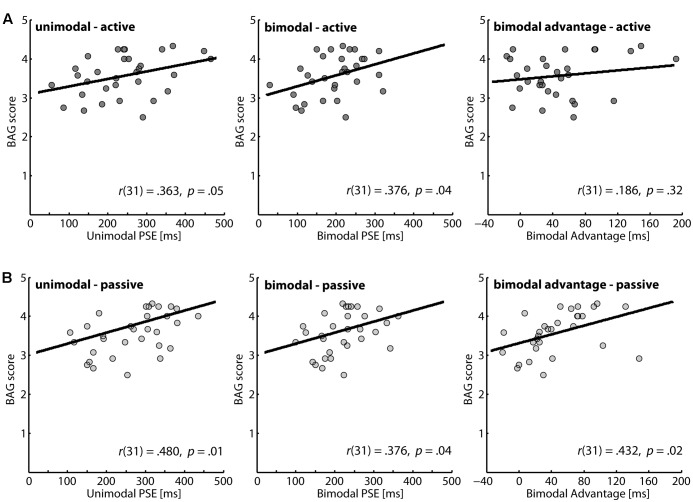
Correlation between brief assessment of gestures (BAG) scores and the perception of action consequences. A higher PSE value indicates a lower performance in the perceptual task. (A) Active condition: the first two panels illustrate data for unimodal and bimodal feedback, respectively; the left panel gives data for the bimodal advantage. (B) Passive condition: the first two panels illustrate data for unimodal and bimodal feedback, respectively; the left panel gives data for the bimodal advantage.